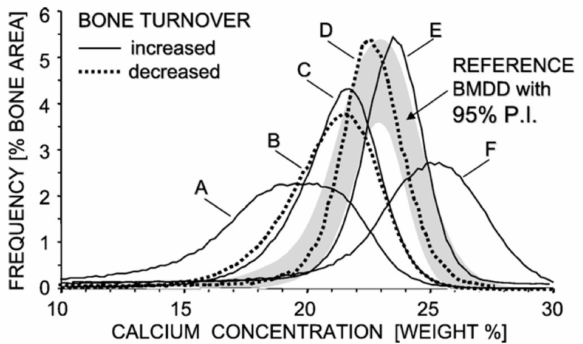
Figure 4. Bone mineralization density distribution (BMDD) of healthy and diseased or treated bone (transiliac biopsies). ( A ): Osteomalacia (celiac disease); ( B ): idiopathic osteoporosis; ( C ): post- menopausal osteoporosis; ( D ): postemenopausal osteoporosis treated with bisphosphonates; ( E ): os- teogenesis imperfecta type I; ( F ) postmenopausal osteoporosis treated with sodium fluoride (repro- duced with permission from ref.